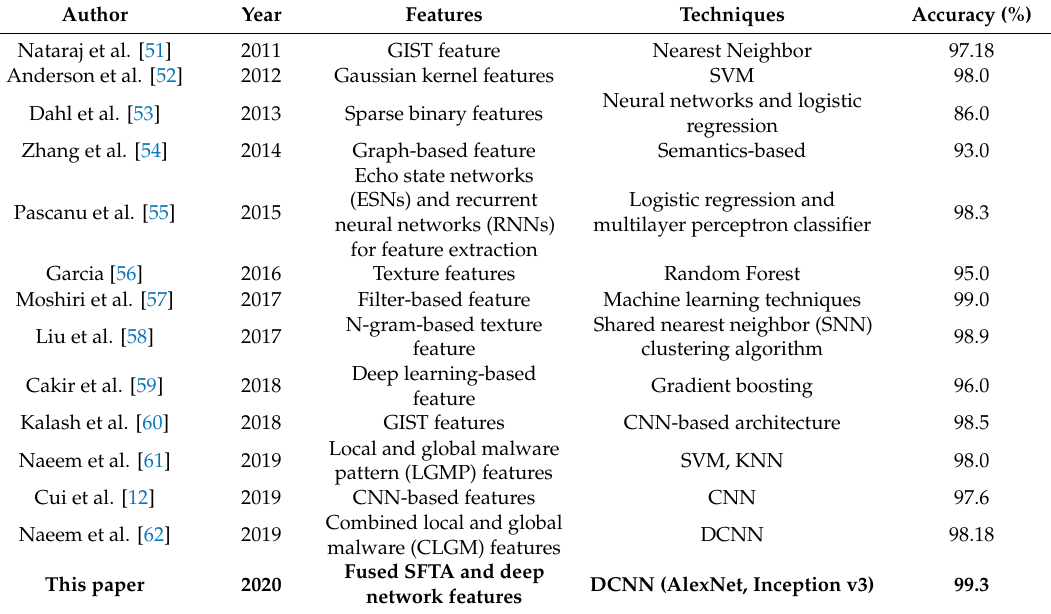
Table 7. Comparison with existing state-of-the-art